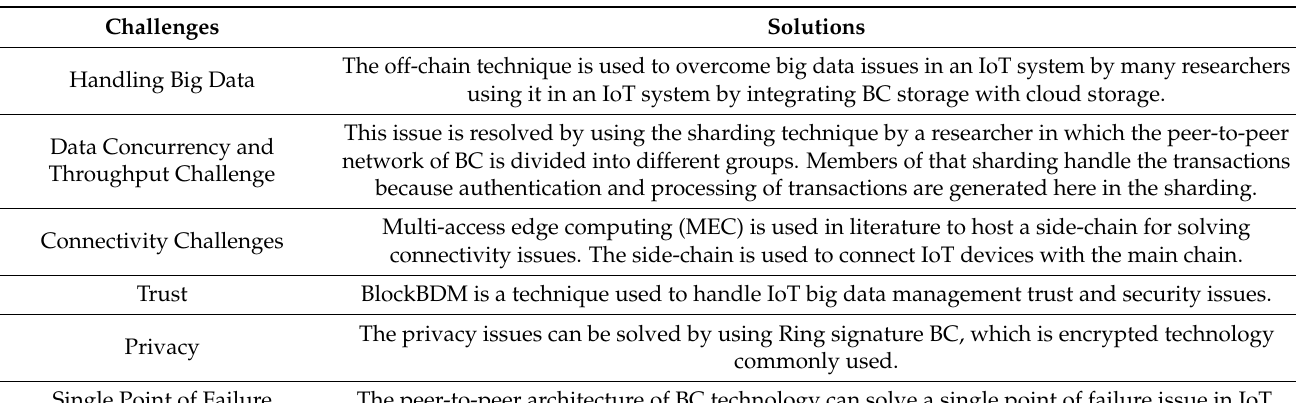
Table 7. Convergence challenges and solutions of BC in